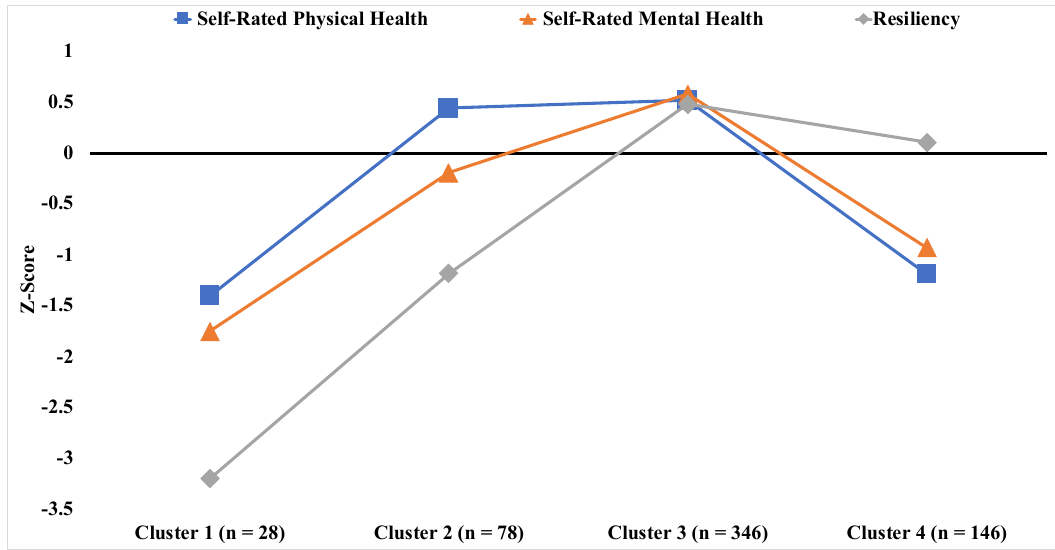
Figure 1. K-means cluster analysis on self-rated physical health, self-rated mental health, and resiliency. Note. n = 598 . Higher Z-scores represent better health, mental health, or resiliency .